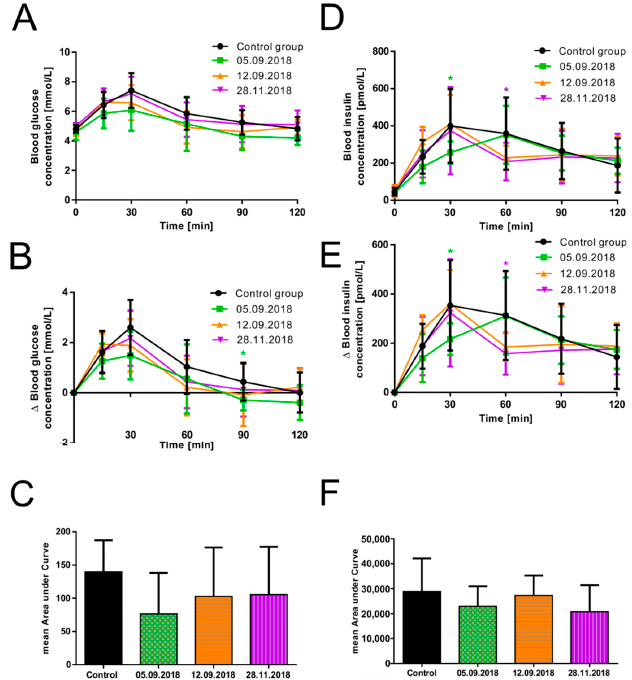
Figure 3. Impact of the storage time of guava fruit extract on its efficacy regarding ( A ) absolute changes in mean postprandial glucose concentration [mmol/L] over 120 min, ( B ) relative changes in mean postprandial glucose concentration [mmol/L], ( C ) calculated mean areas under curve based on relative changes in glucose responses, ( D ) absolute changes in mean postprandial insulin responses [pmol/L] over 120 min, ( E ) relative changes in mean postprandial insulin responses [pmol/L], and ( F ) calculated mean areas under curve based on relative changes in insulin